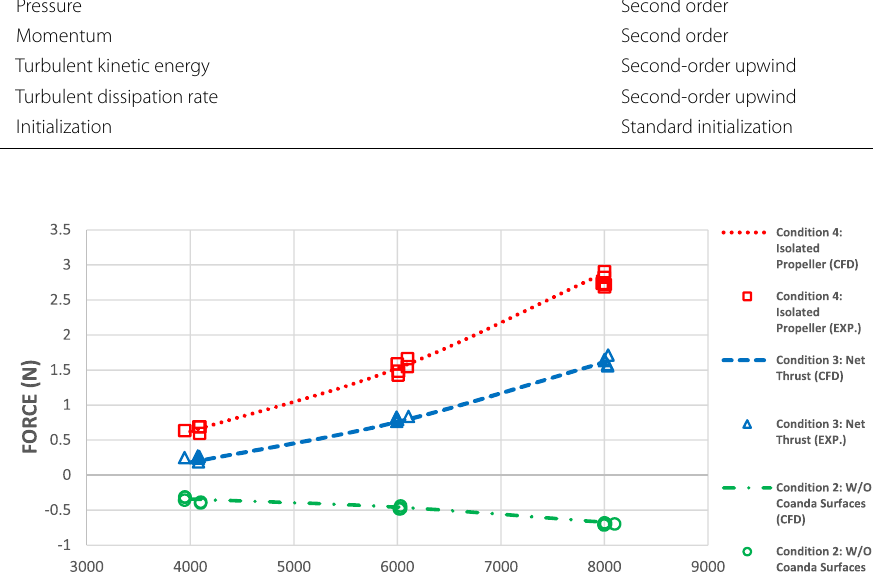
Fig. 7 Thrust vs RPM results for loading conditions 2, 3, and